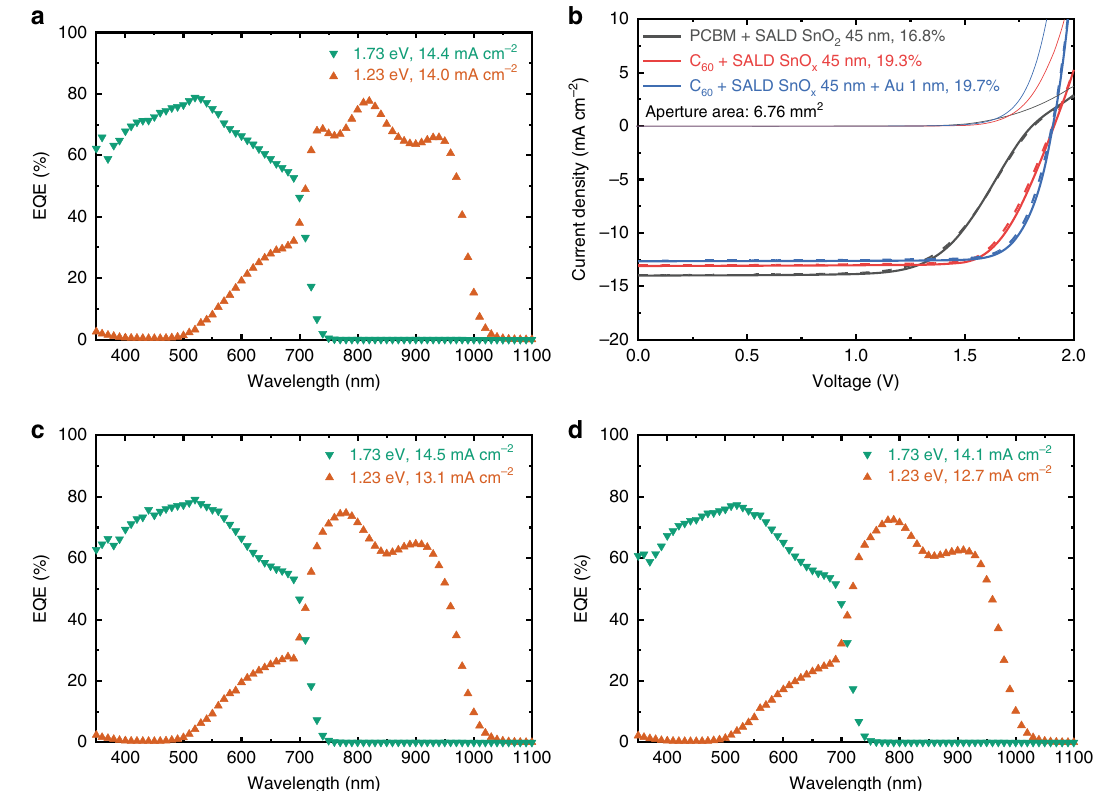
Fig. 2 Photovoltaic performance of monolithic all-perovskite tandem solar cells. EQE spectra of 1.73 eV wide bandgap and 1.23 eV narrow bandgap sub- cells in a tandem device. a For a PCBM/SALD-SnO 2 /PEDOT:PSS, ICL. c For a C 60 /SALD-SnO 2 /PEDOT:PSS ICL. d For a C 60 /SALD-SnO 2 /Au/PEDOT:PSS ICL. The J sc was obtained by integrating with the AM1.5G spectrum. b Fast dark and light J – V scans of tandem cells with different ICLs (measured with 6.76 mm 2 aperture area). Source data are provided as a Source Data fi